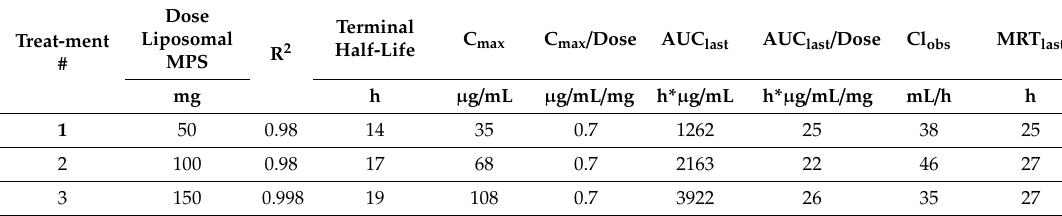
Figure 7. Levels of MPS and MP in the patient’s serum for treatments 1–3. ( A ) MP to MPS ratio (mole %) during time following 1-hour slow infusion of NSSL-MPS for treatment 1, 2 and 3. ( B ) Serum levels (as percent of injected dose) of methylprednisolone hemisuccinate following 1-hour slow infusion of NSSL-MPS for treatment 1, 2 and 3 (treatment with 50, 100 and 150 mg liposomal MPS respectively). Table 1. Pharmacokinetics